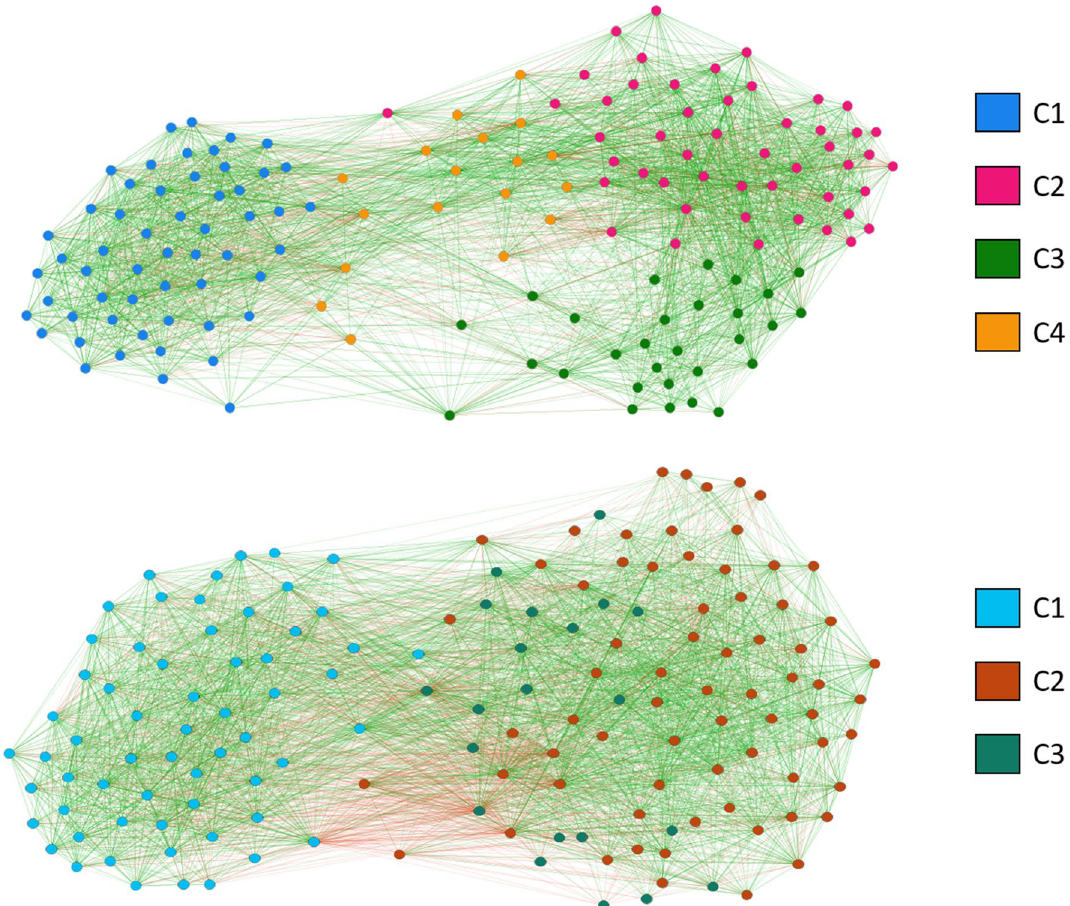
Figure 6. Network representation of all the social relations in wave 1 (top) and wave 2 (bottom). Nodes belonging to each community are marked by color as indicated in the plot. Friendship links are drawn in green, whereas enmity links are drawn in